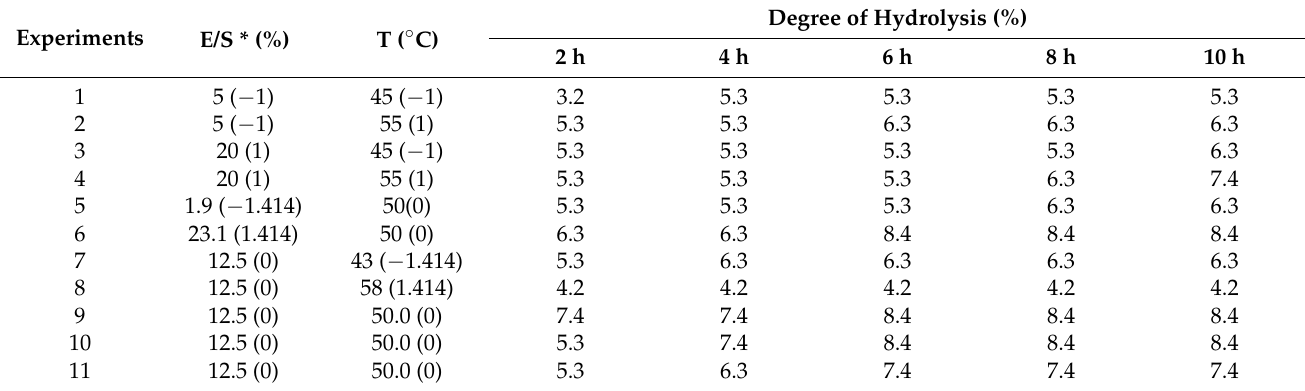
Table 2. Design of experiments 2 2 enzymatic hydrolysis (Savinase ® ) of ground chicken feathers. Experiments